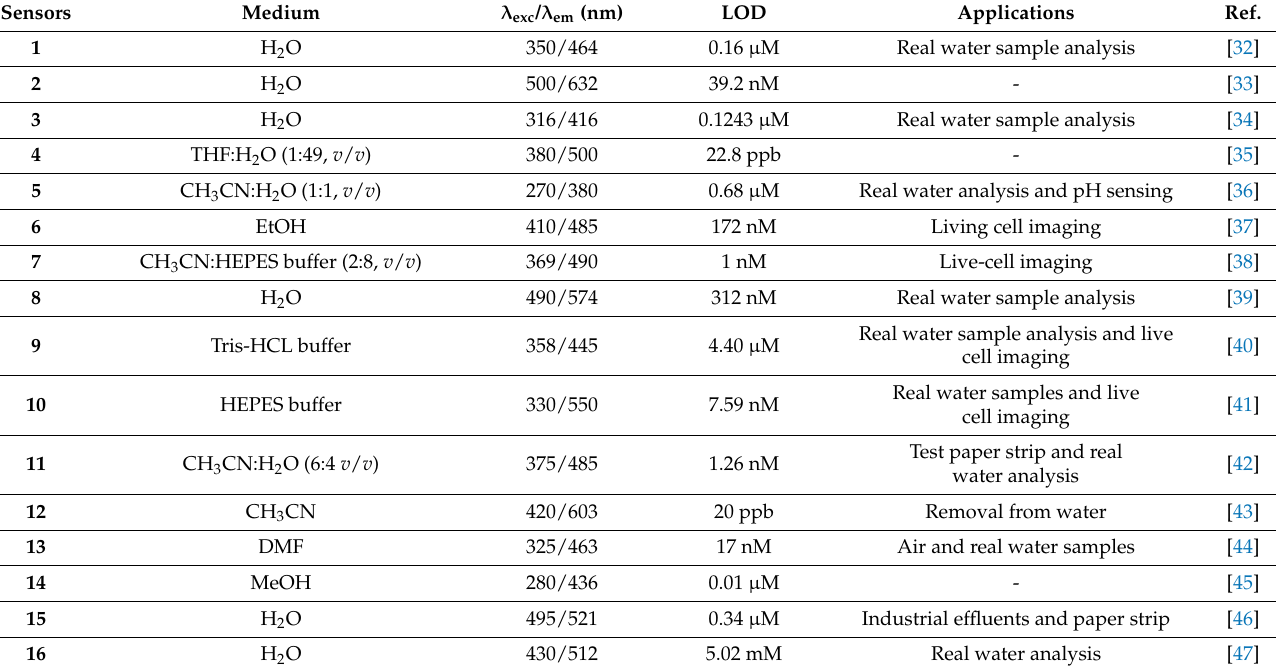
Table 2. Analytical parameters for the fluorescent sensors 1 to 84